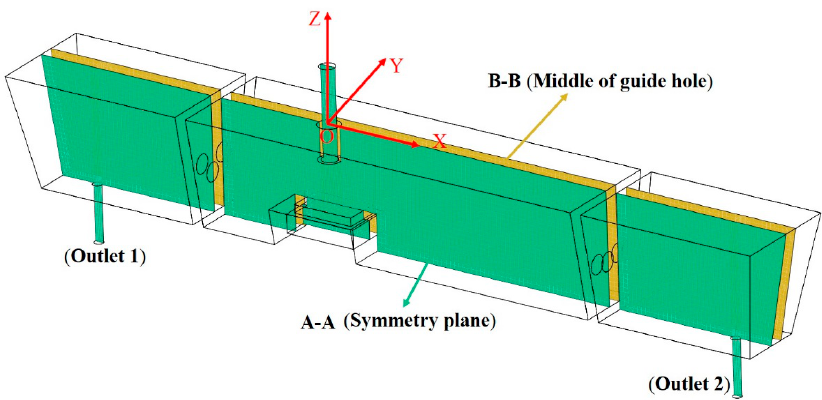
Figure 4. Characteristic sections in the tundish.